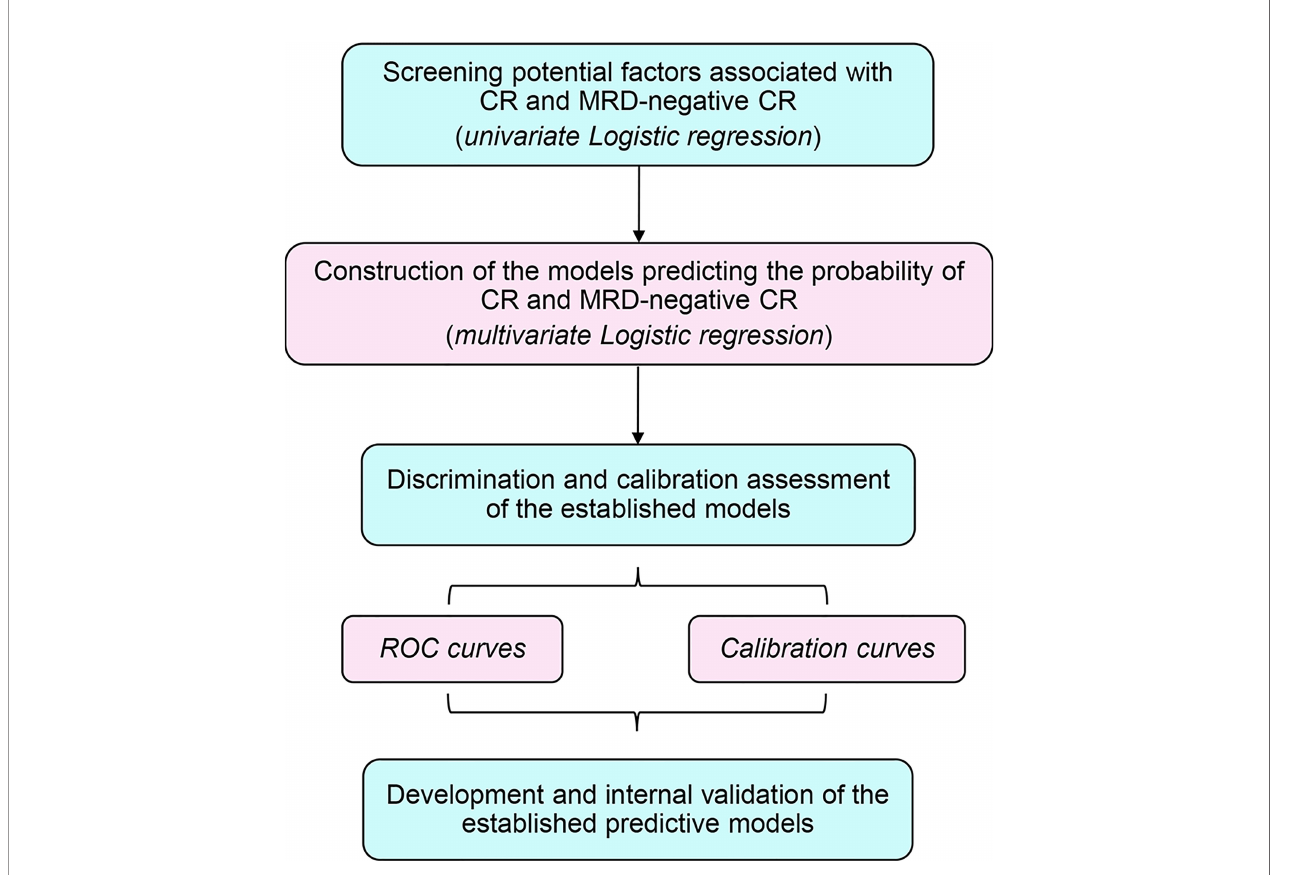
FIGURE 1 | Flowchart of the analytic process of this